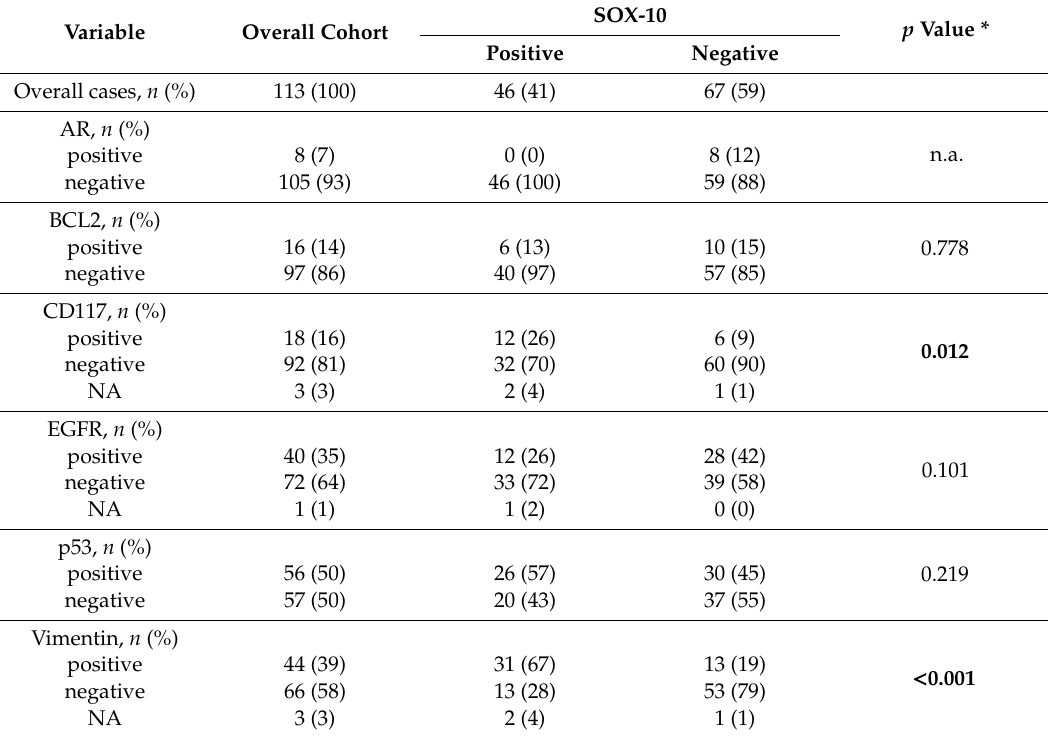
Table 2. Immunohistochemical characteristics with regard to SOX-10